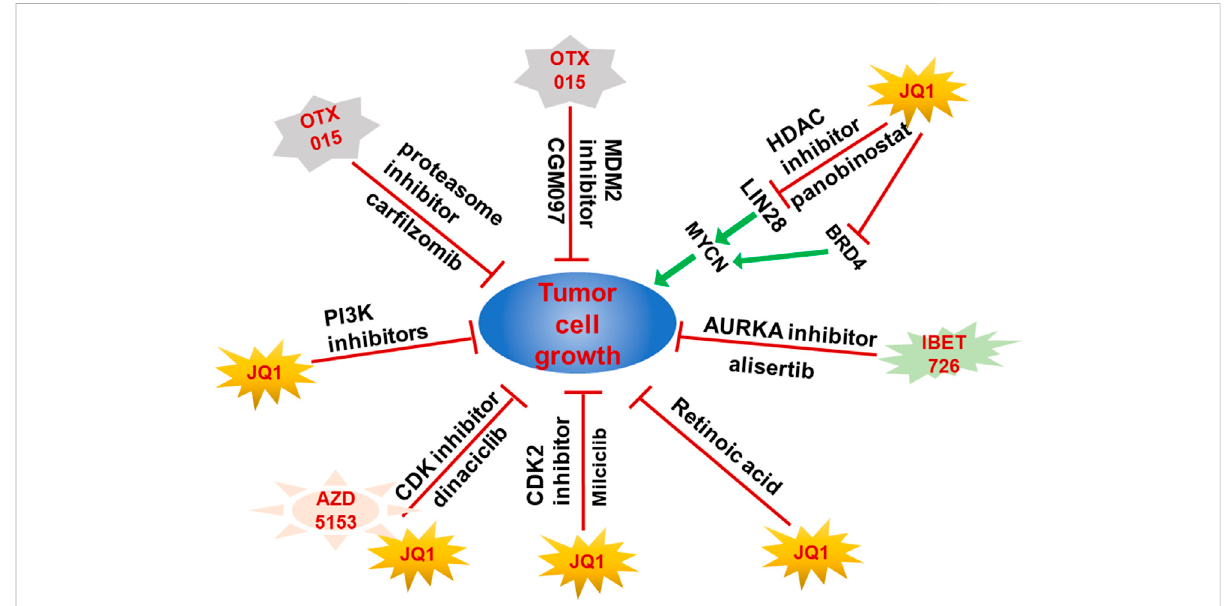
FIGURE 2 Combination of BET proteins inhibitors and other drugs achieved better therapeutic effect on NB growth. Resistance to BET proteins inhibitors hamperedtheirclinicalapplication.CombinationofBETproteininhibitorswithothersmallmolecularinhibitorsexhibitedsynergisticinhibitioneffect on NB tumors by targeting both MYCN and other genes upregulated or activated in resistance NB